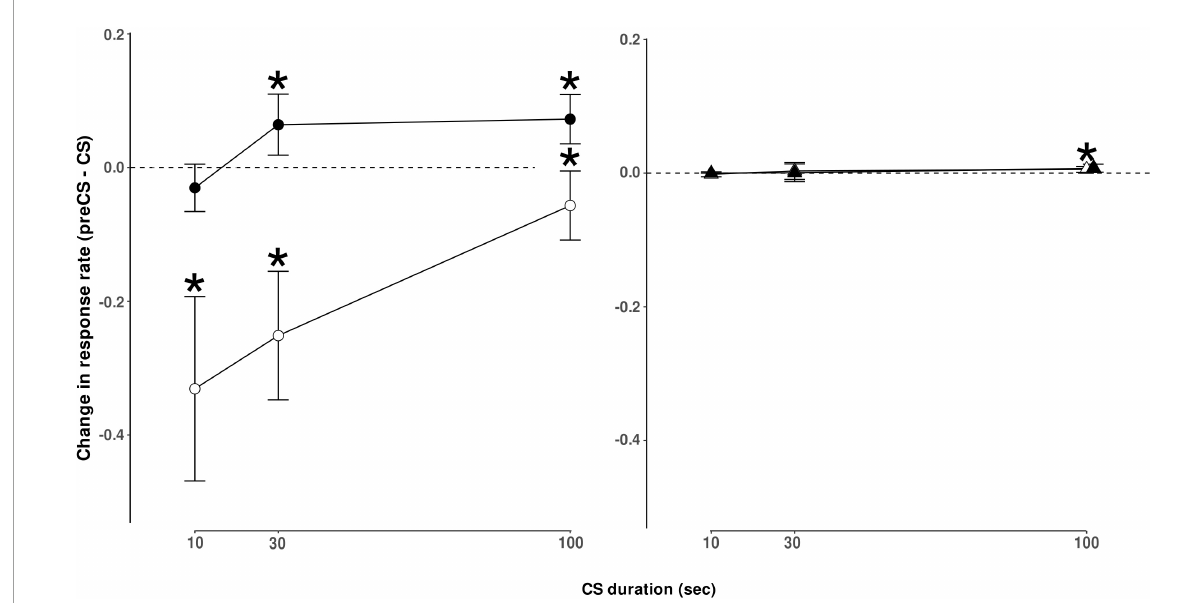
FIGURE2 Left panel–On-target responding. Change in responding on the ethanol-lever during components where ethanol was available ( • ) or change in responding on the food-lever when food was available ( ◦ ) during CS presentation. Results are presented as the number of responses observed during CS presentation minus responses observed during the period immediately before CS presentation. This measure reflects the relative increase or decrease in responding during CS presentation of varying durations. CS presentation duration varied as indicated, 10-s, 30-s, or 100-s. Points represent mean change ± S.E.M. for n = 6 rats. *Indicates points that differ significantly from zero (no change), p < 0.05 after correction for multiple comparisons. Right panel–Off-target responding. Change in responding on the ethanol-lever during components where food was available ( (cid:78) ) or on the food-lever when ethanol was available ( (cid:49) ). Results are reported as responses observed during CS presentation minus responses observed during the period immediately before CS presentation. CS presentation duration varied as indicated, 10-s, 30-s, or 100-s. Points represent mean change ± S.E.M. for n = 6 rats. Points above 100-s CS presentation have been adjusted to show that responding for food was significantly increased ( p < 0.05) in the ethanol component, but not responding for ethanol in the food